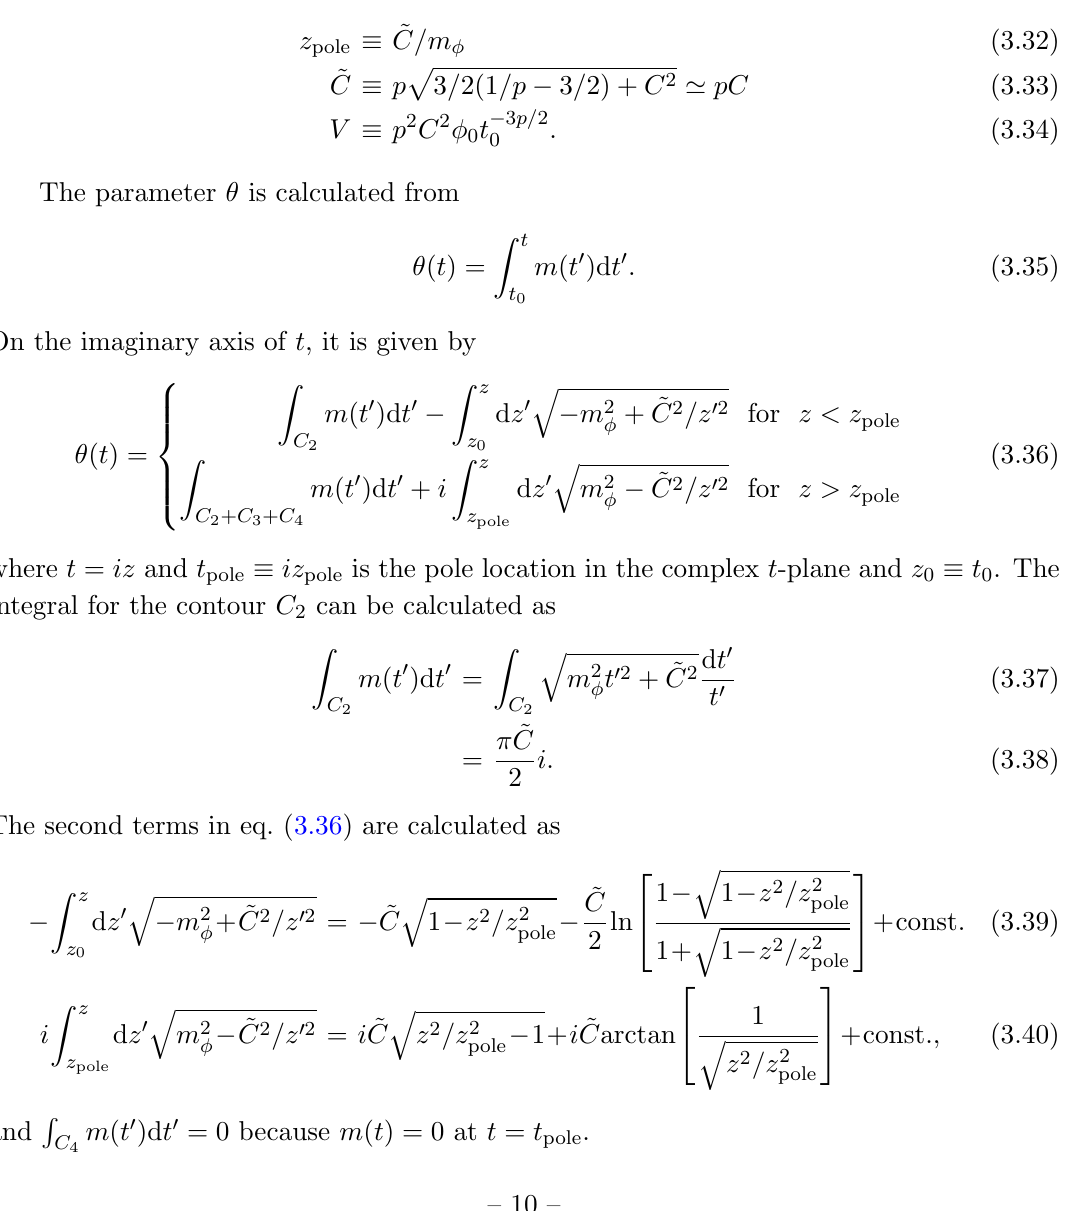
Figure 1 . Integration contours in the complex t plane for the cases of m a = const : (left panel) and m a / t n= 2 (right panel). The red lines represent branch cuts and the red points are poles. where we